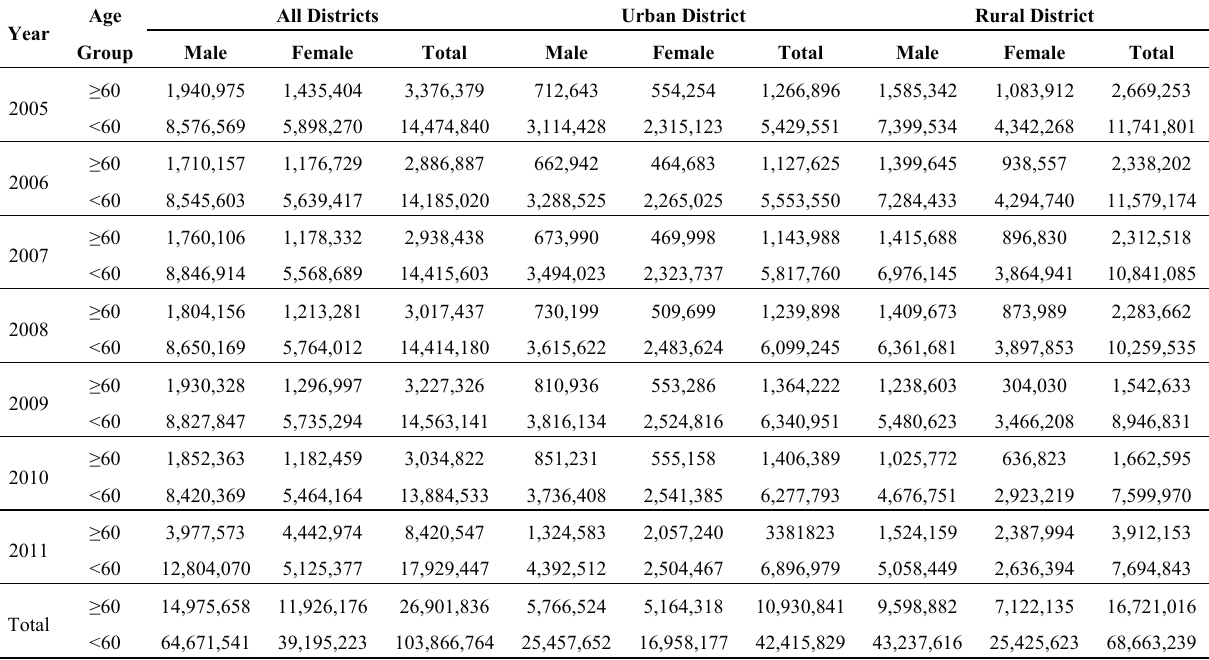
Table 5. Potential years of life lost for the elderly ( ≥ 60 years) and young (<60 years) populations in China,